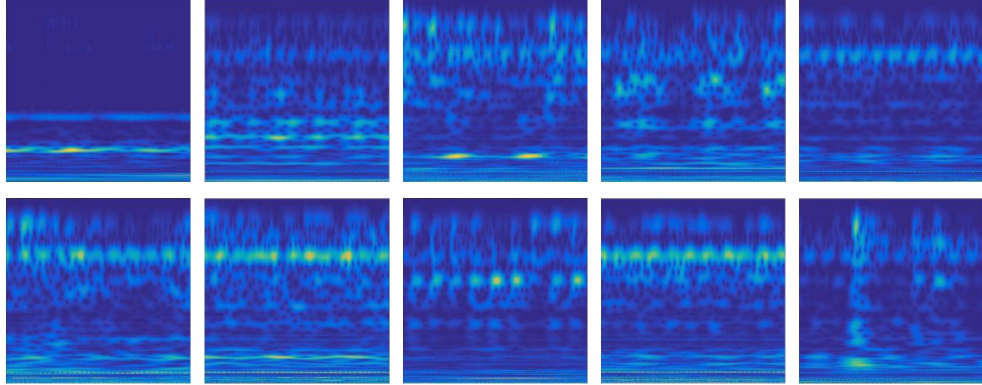
Figure 6. Time frequency diagram of fault samples after wavelet conversion.